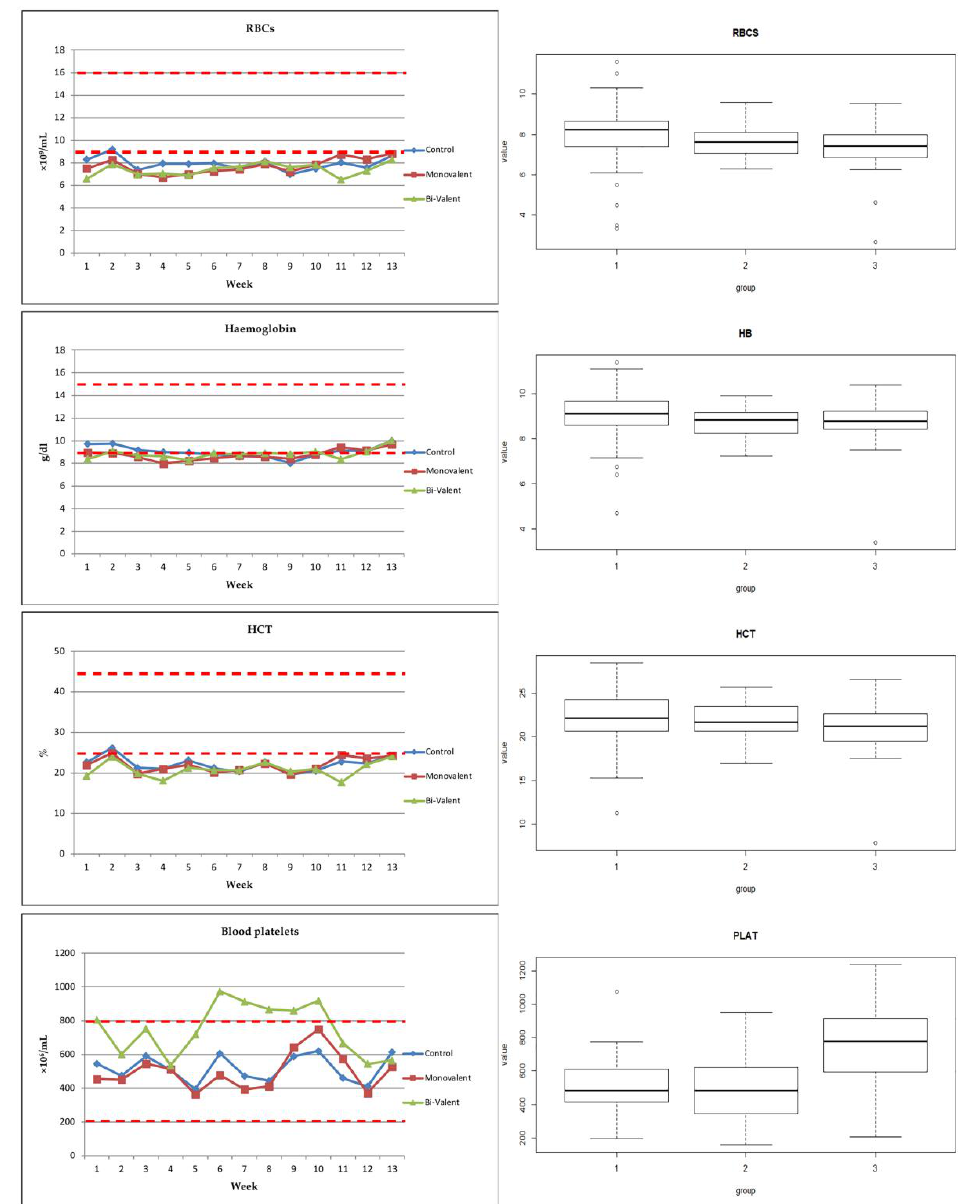
Figure 2. Total and differential leukocyte count (graphs and boxplots). WBCs: total leukocytic count; NEU: neutrophils; LYM: lymphocytes; MONO: monocytes; EOS: eosinophils; group 1 (control), group 2 (mono-valent vaccine), group 3 (bi-valent vaccine); the red dotted line refers to the physio- logical threshold of the parameter value in ovine species.